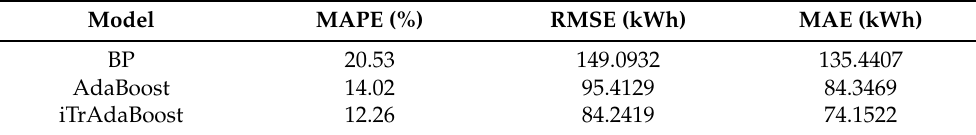
Figure 9. Real and predicted electricity loads using three predictive models, ratio of training data from target domain: 30%, one week’s data. Table 3. Performance comparison of the three predictive models without MMD similarity